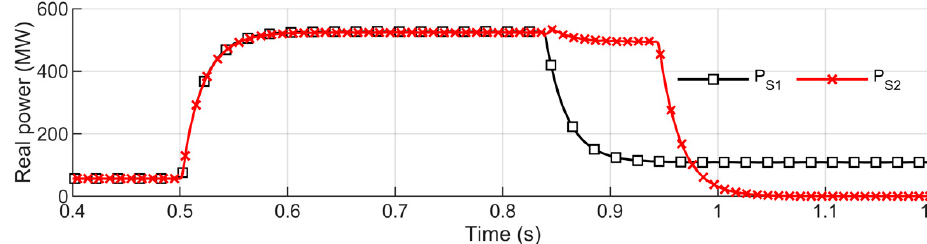
Figure 19. Currents in HTS cables in case DCR fails: ( a ) HTS 1 ; ( b ) HTS 2 .